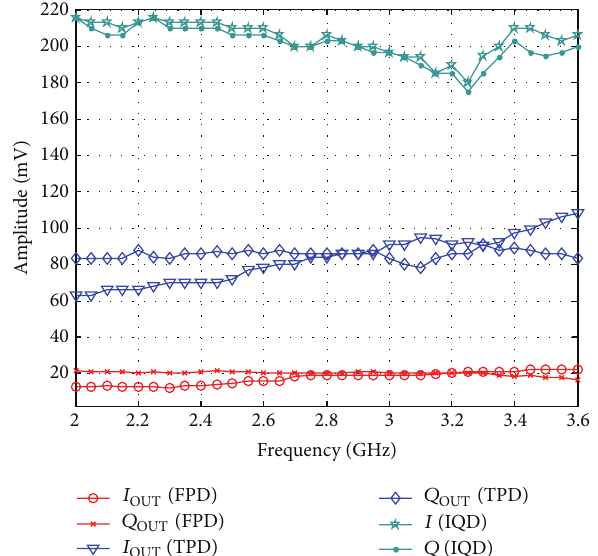
= 5 dBm, 𝑃 = −25 dBm, and Δ𝑓 = 10 kHz). LO RF